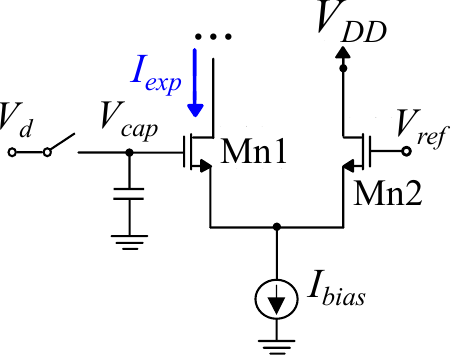
Figure 10. A schematic of a simple exponential generation circuit.